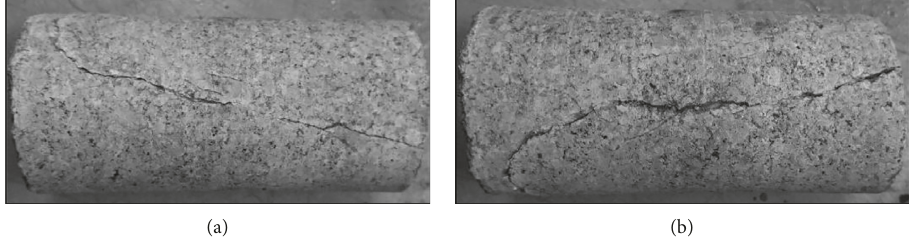
Figure 7: Thermal cracking diagram of granite specimens with the high initial damage. (a) Initial axial compression is 80% of UCS. (b) Initial axial compression is 90% of